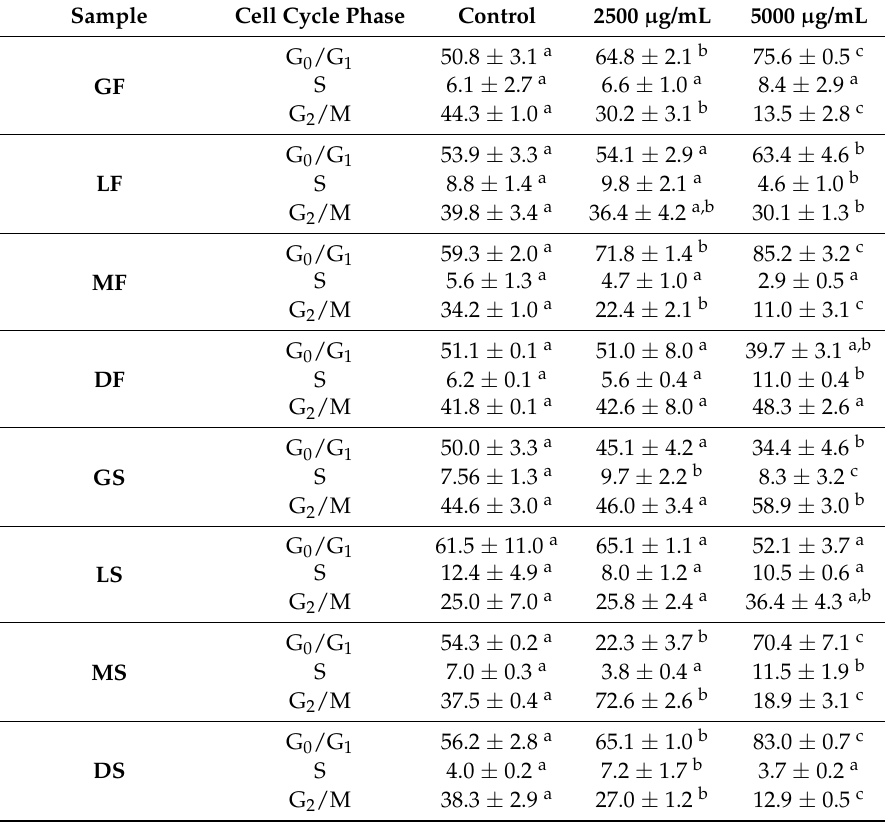
Table 4. Effects of freeze-dried and spray-dried coffee extracts (2500 and 5000 µ g/mL) on cell cycle progression in human prostate cancer cell line after 24 h of